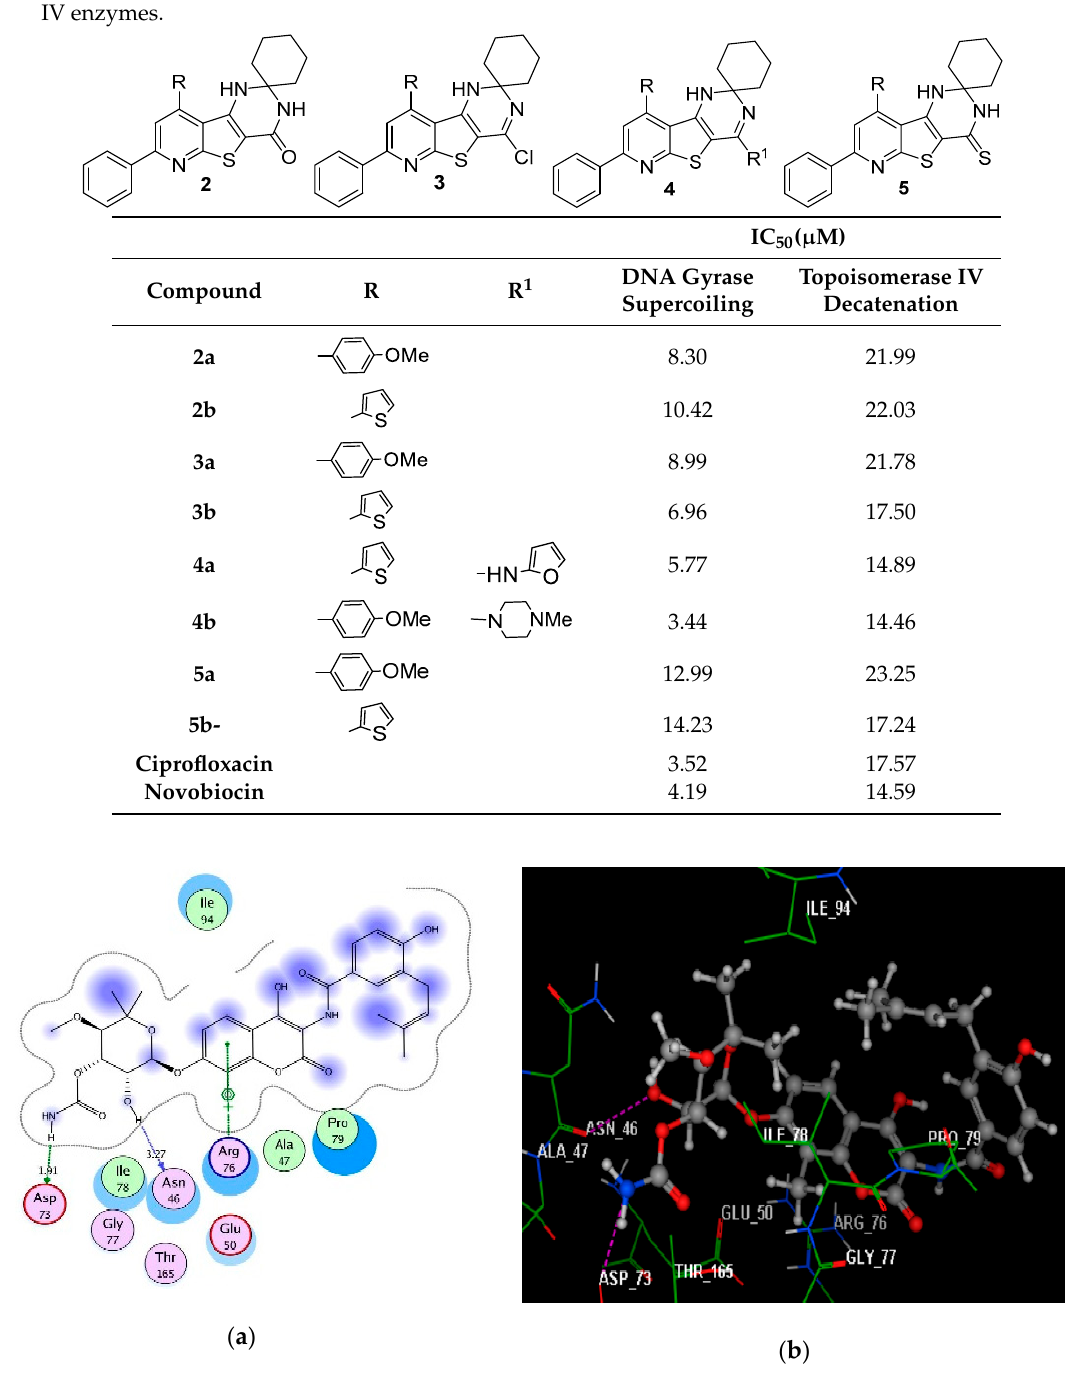
Table 2. Inhibitory activity of some selected compounds against E. coli DNA gyrase and topoisomerase